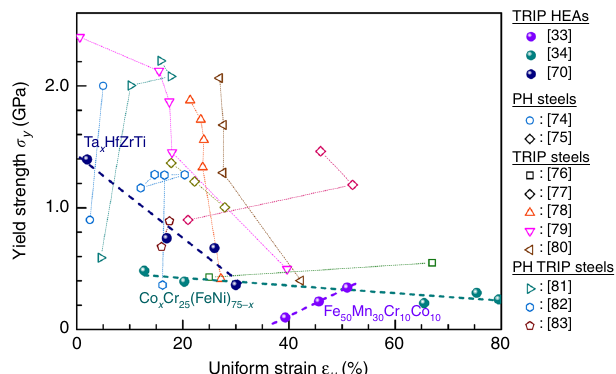
Fig. 7 Yield strength versus uniform tensile strain observed in recently reported multi-principal-element steels. These advanced steels use TRIP and TWIP effects to boost strain